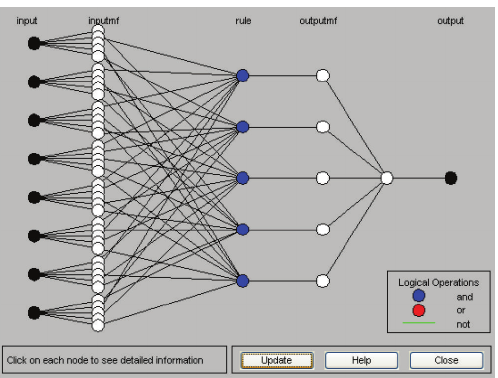
Figure 7: Structure of the developed dynamic NF model for the affective design of mobile phones.